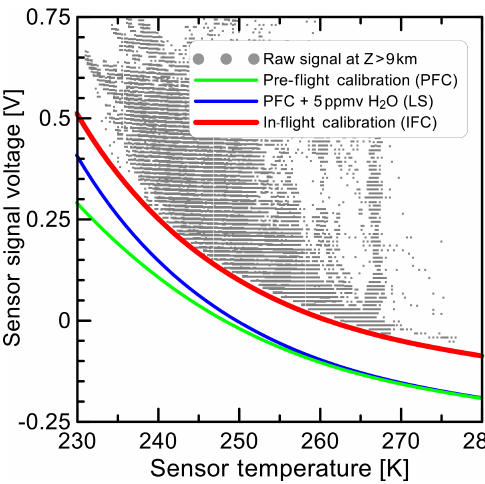
Figure 2. Raw signal of the MOZAIC humidity sensor on board one MOZAIC aircraft as a function of the sensor temperature inside the aeronautic housing obtained at cruise altitude ( z = 9–12km). Green line: zero signal from pre-flight calibration (PFC); blue line: superposition of zero signal from PFC and contribution of 5ppmv water vapour; red line: zero signal from in-flight calibration